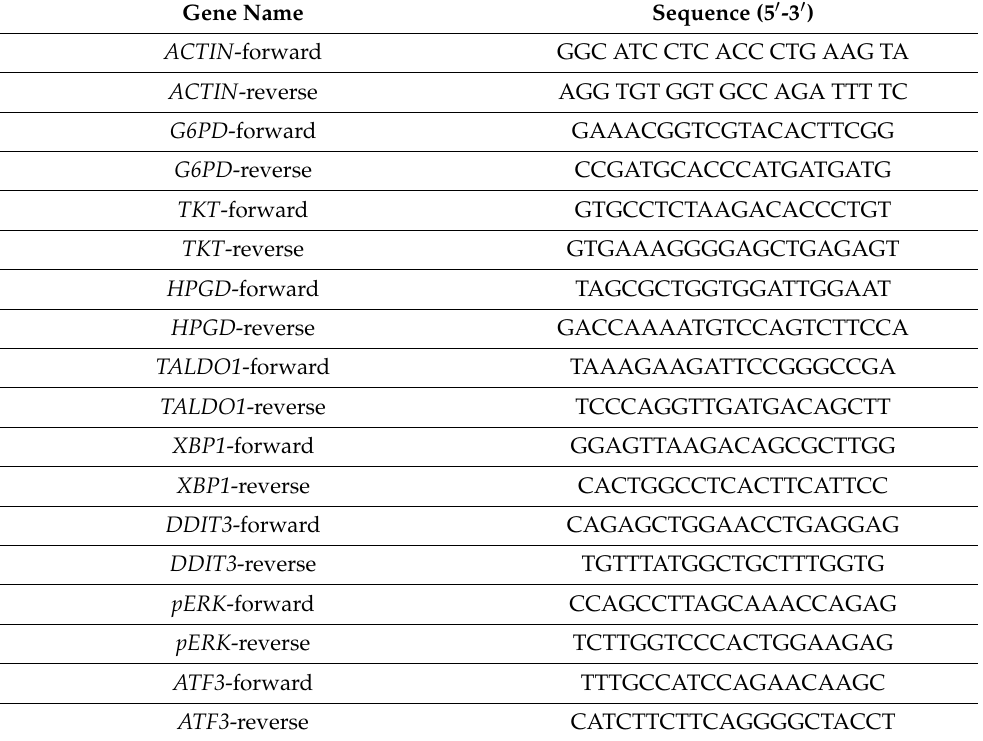
Table 1. List of primer sequences used in this